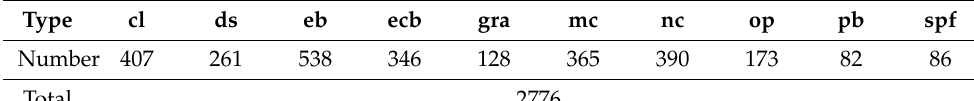
Table 1. Number of aluminum profile defect images of each type.